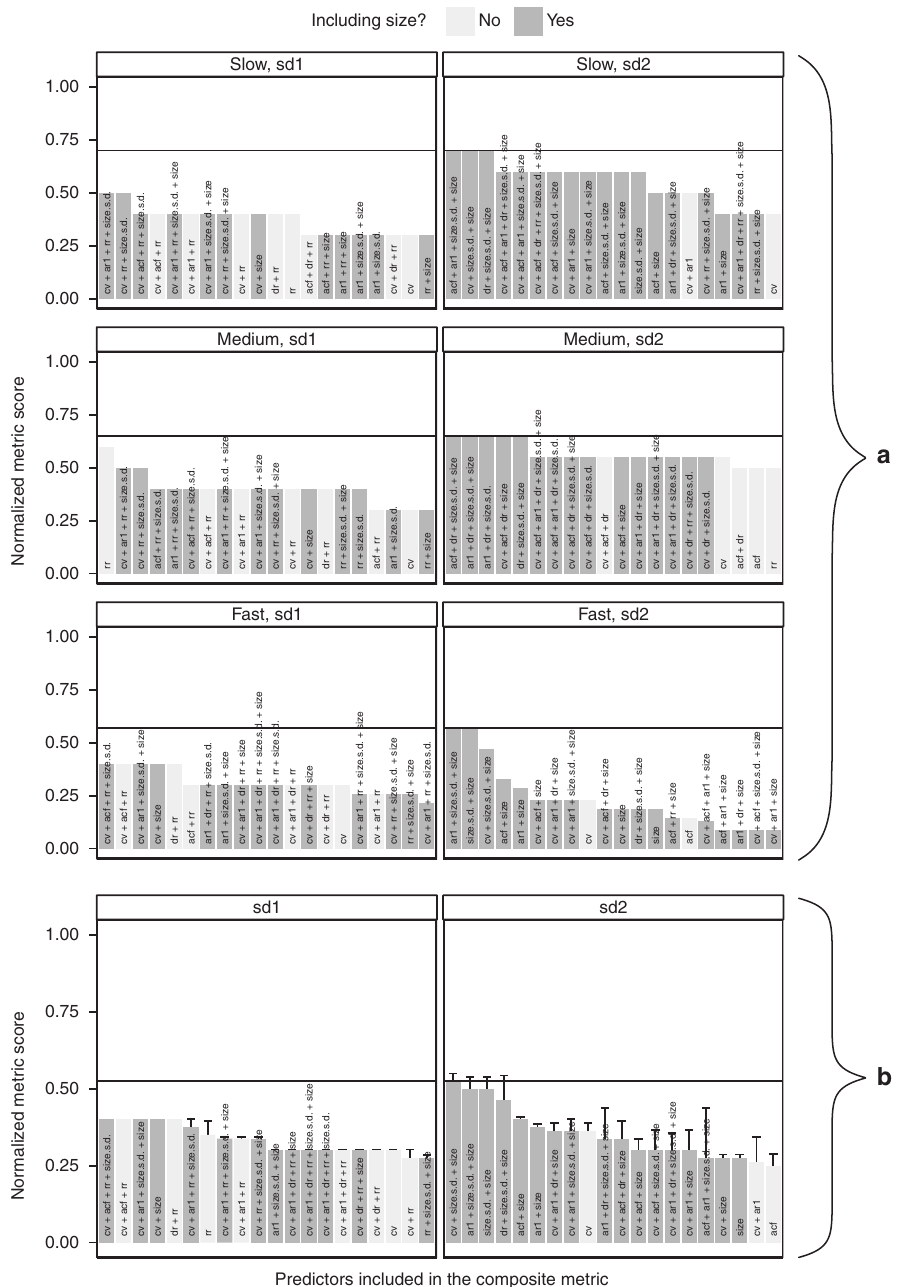
Figure 3 | Performance of early warning metrics when including or excluding information on trait dynamics. ( a ) The 20 combined metrics with the highest normalized metric score in each treatment group, and ( b ) across all treatment groups, with an early warning threshold set at one or two s.d.’s. Including size within the early warning index increased the predictive accuracy across all treatments at a 2 s threshold. At a 1 s threshold including size improved on or matched the accuracy of other combined metrics in all treatments apart from the medium rate of change, where return rate was the most reliable indicator. Horizontal black lines show the highest normalized metric score in each treatment. Bars indicate the variance in predictive accuracy of each metric across the three different deterioating experimental treatments. acf, autocorrelation; ar1, autoregressive coefficient; cv, coefficient of variation; dr, density ration; rr, return rate; size, mean body size; size.s.d., s.d. of body size.